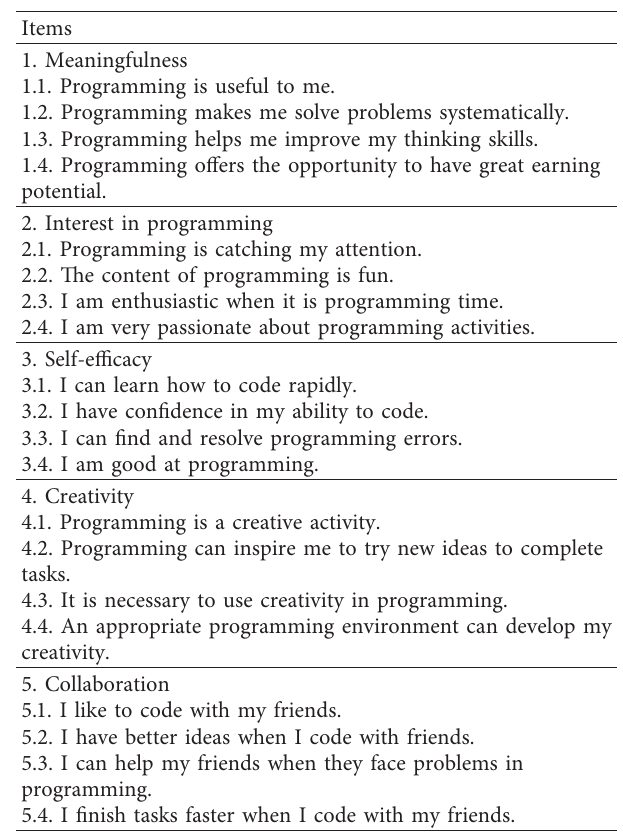
Table 1: Students’ classification. Table 3: Survey items of the instrument.